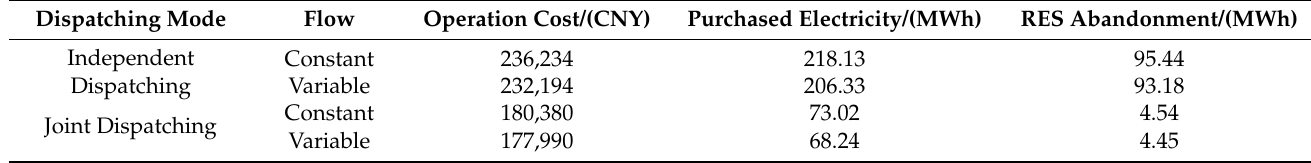
Table 4. System operation cost, purchased electricity, and RES abandonment under different dispatching